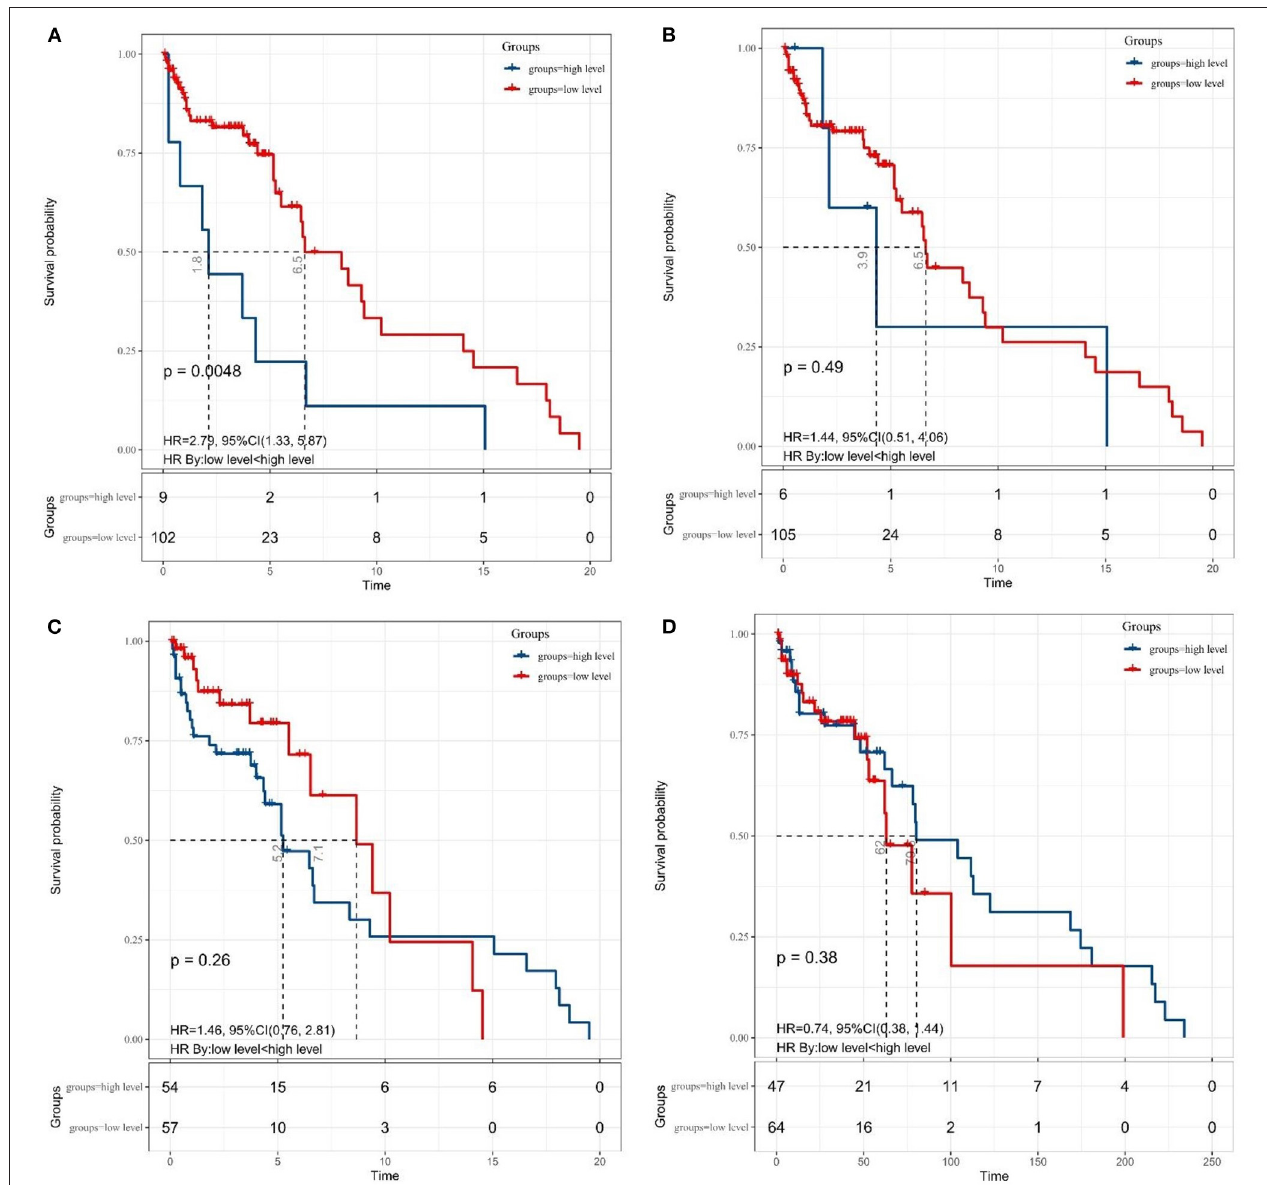
FIGURE 2 | The Kaplan–Meier survival curves for OS according to (A) SII, (B) NLR, (C) MLR, and (D) PNI in patients with medulloblastoma. SII, systemic immune-inflammation index; NLR, neutrophil–lymphocyte ratio; MLR, monocyte–lymphocyte ratio; PNI, prognostic nutritional index.